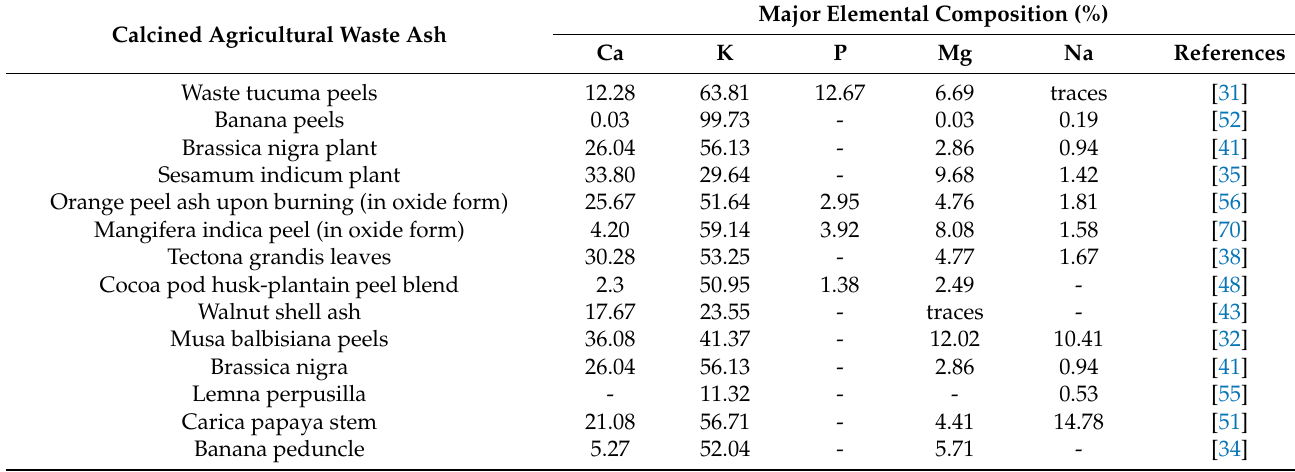
Table 2. Elemental composition of differently sourced agricultural